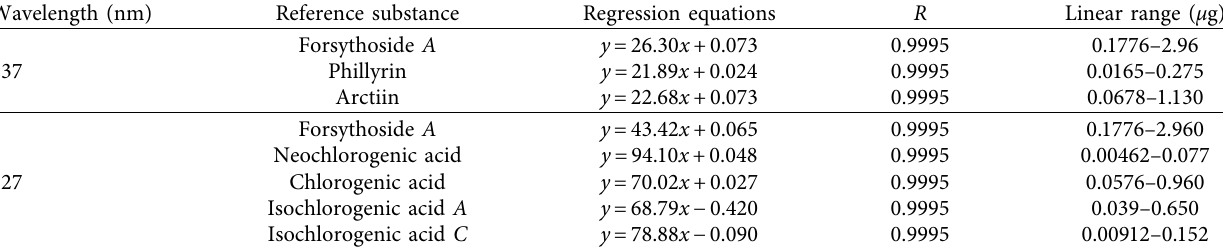
Table 6: Linear regression equation of seven reference